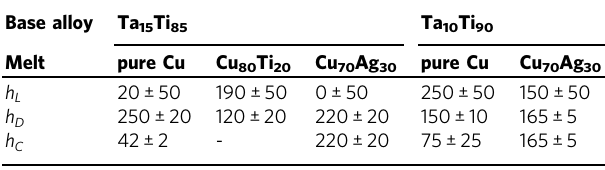
The de fi nition of the thickness of Ta leak h L , the thickness of the dealloyed structure h D , and the thickness of the connected structure h C are shown in Fig. 4a. The unit of all measurements are μ